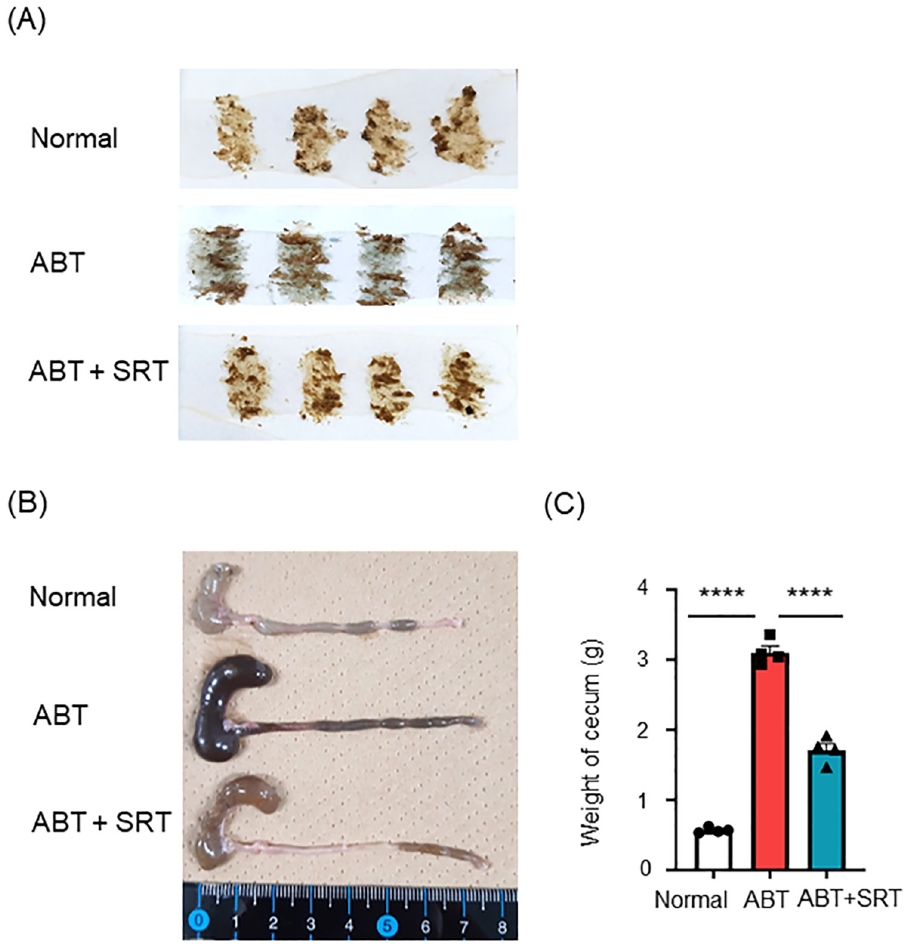
Fig 1. Effect of Saireito on antibiotic-induced fecal occult bleeding and cecum enlargement. Mice in the normal group were given a normal diet and normal drinking water; ABT group mice were given a normal diet and A + V solution in drinking water for the last 7 days; ABT + SRT group mice were fed a 1.5% Saireito diet until the last day and given A + V solution in drinking water for the last 7 days. (A) Images of fecal occult bleeding test (FOBT) on day 28. If FOBT is positive, it will turn blue. (B) Graph shows the images of large intestines. (C) Bar graphs show the weight of cecums. Statistical analysis was carried out using one-way ANOVA followed by Tukey’s multiple comparisons test. Data are shown as mean ± SEM (n = 4, each group). ���� P < 0.0001.